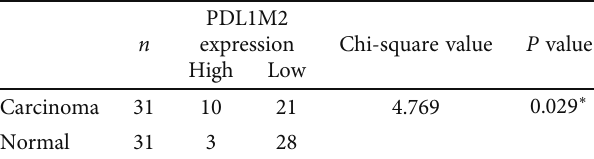
Figure 8: IHC staining of PDLIM2 in prostate cancer samples. (a) Protein expression of PDLIM2 in normal prostate tissues; (b) weak, (c) moderate, and (d) strong positive expression of PDLIM2 protein in prostate cancer tissues. Table 2: Di ff erential expression of PDLIM2 in cancerous and noncancerous prostate